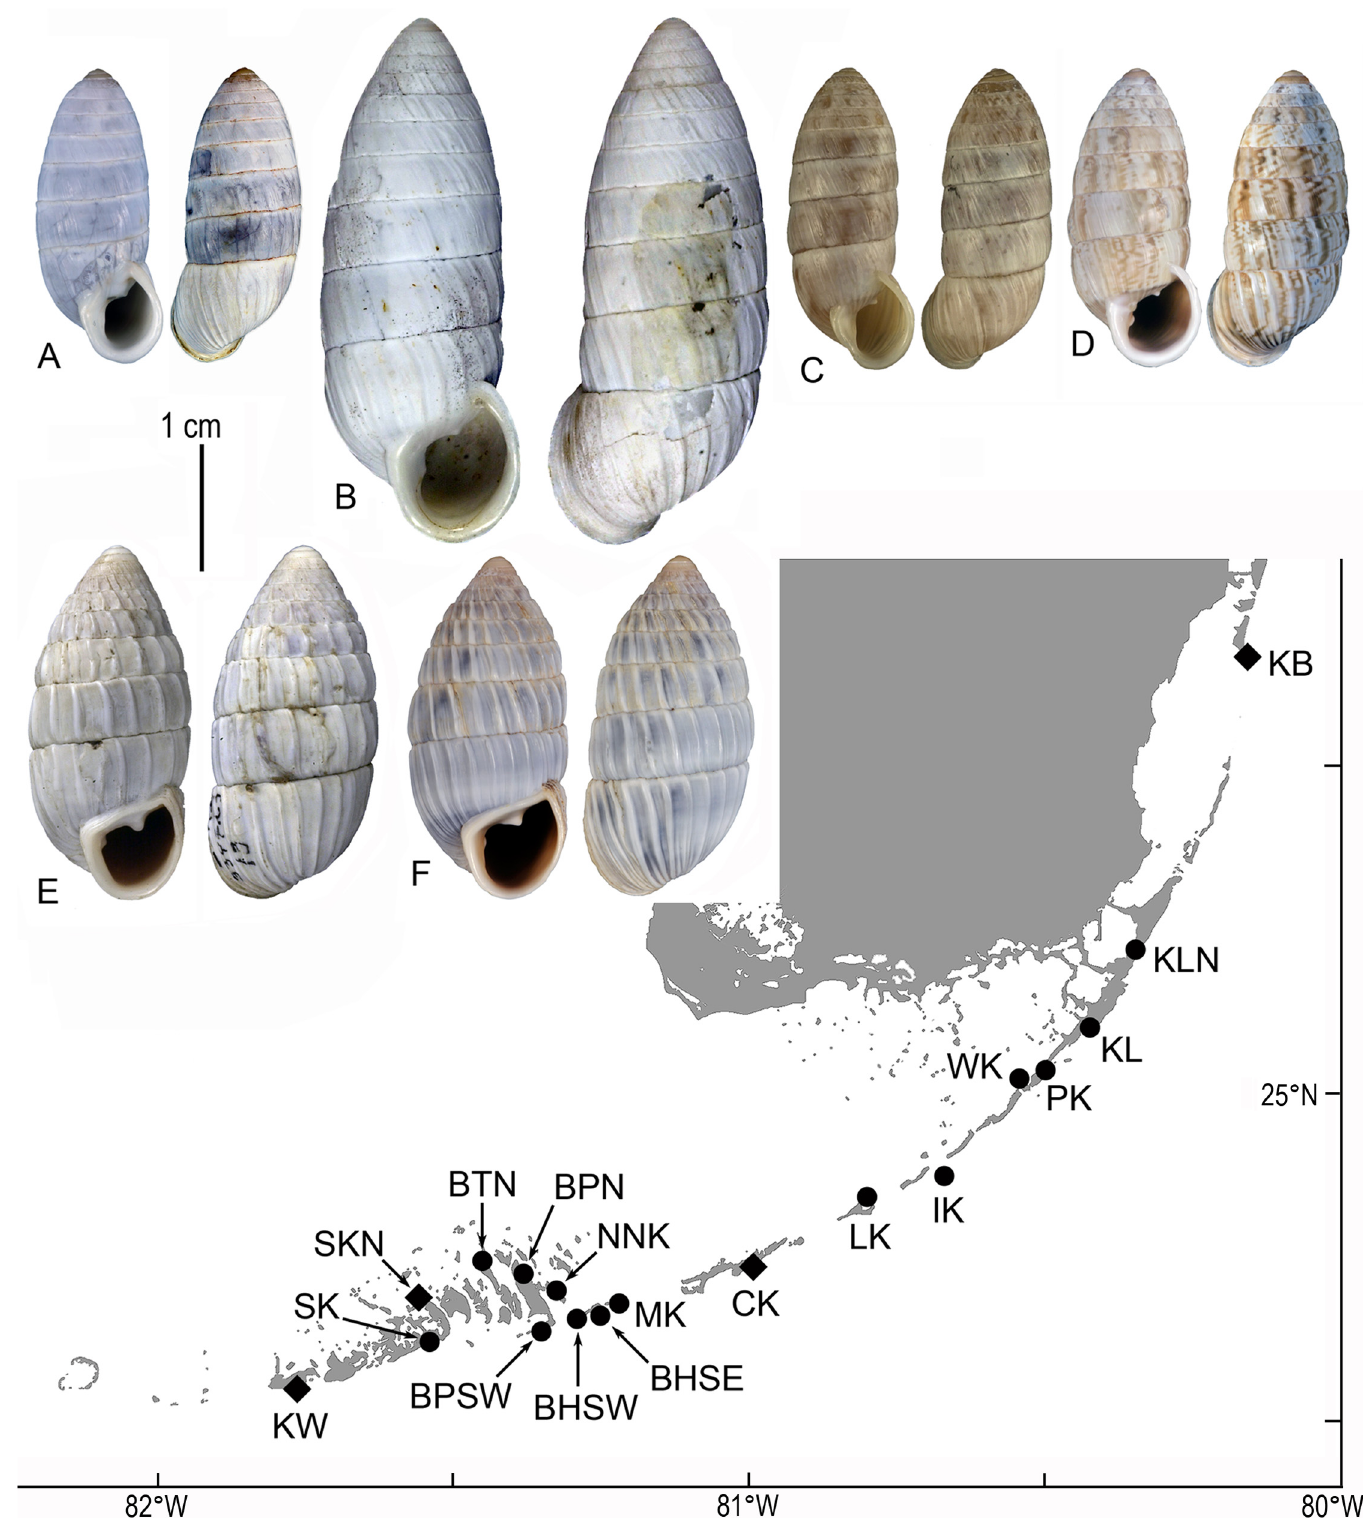
Fig 1. Locations of sampled populations and exemplars of phenotypes of Cerion encountered in this study: A. Cerion incanum incanum (Leidy, 1851), neotype, USNM 1231355, Key West. B. Cerion incanum saccharimeta Pilsbry & Vanatta, 1899, lectotype, ANSP 73483, Sugar Loaf Key.